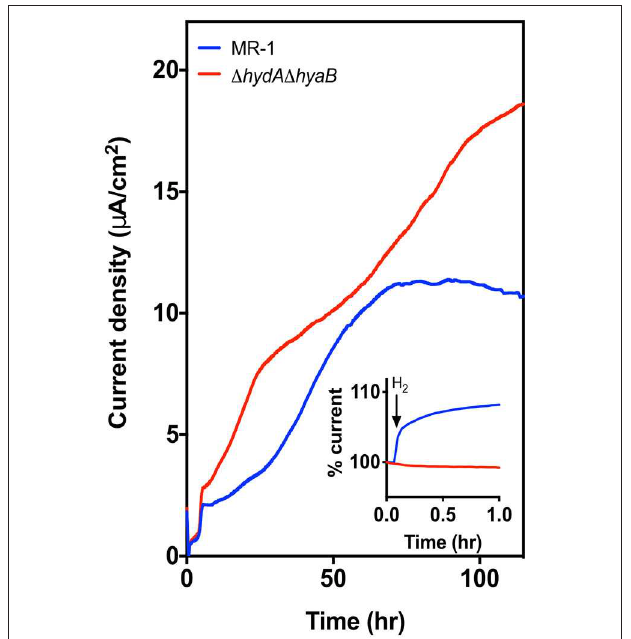
FIGURE 2 | Deletion of hydrogenases results in higher current density. Current density produced by MR-1 (blue) vs. 1 hydA 1 hyaB (red) in anaerobic bioreactors with vented cathodes. Lactate was supplied as the carbon source, and graphite carbon anodes were poised at + 0.240V vs. SHE. Data represents average current density produced in reactors run in triplicate. Inset figure shows the response in current production to addition of 1% exogenous hydrogen into the reactor headspace, with level of current at time of injection represented as